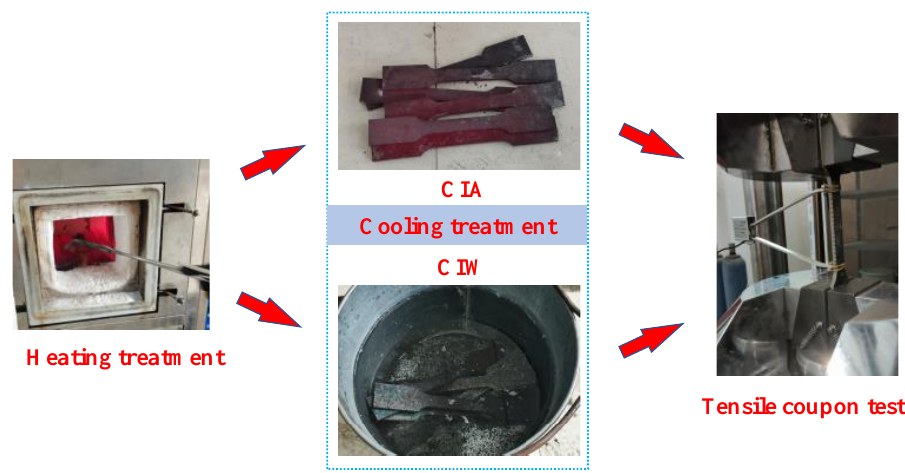
Figure 3. Process of the material test (CIA: cooling in air; CIW: cooling in water). Table 1. Q690 HSS chemical composition.